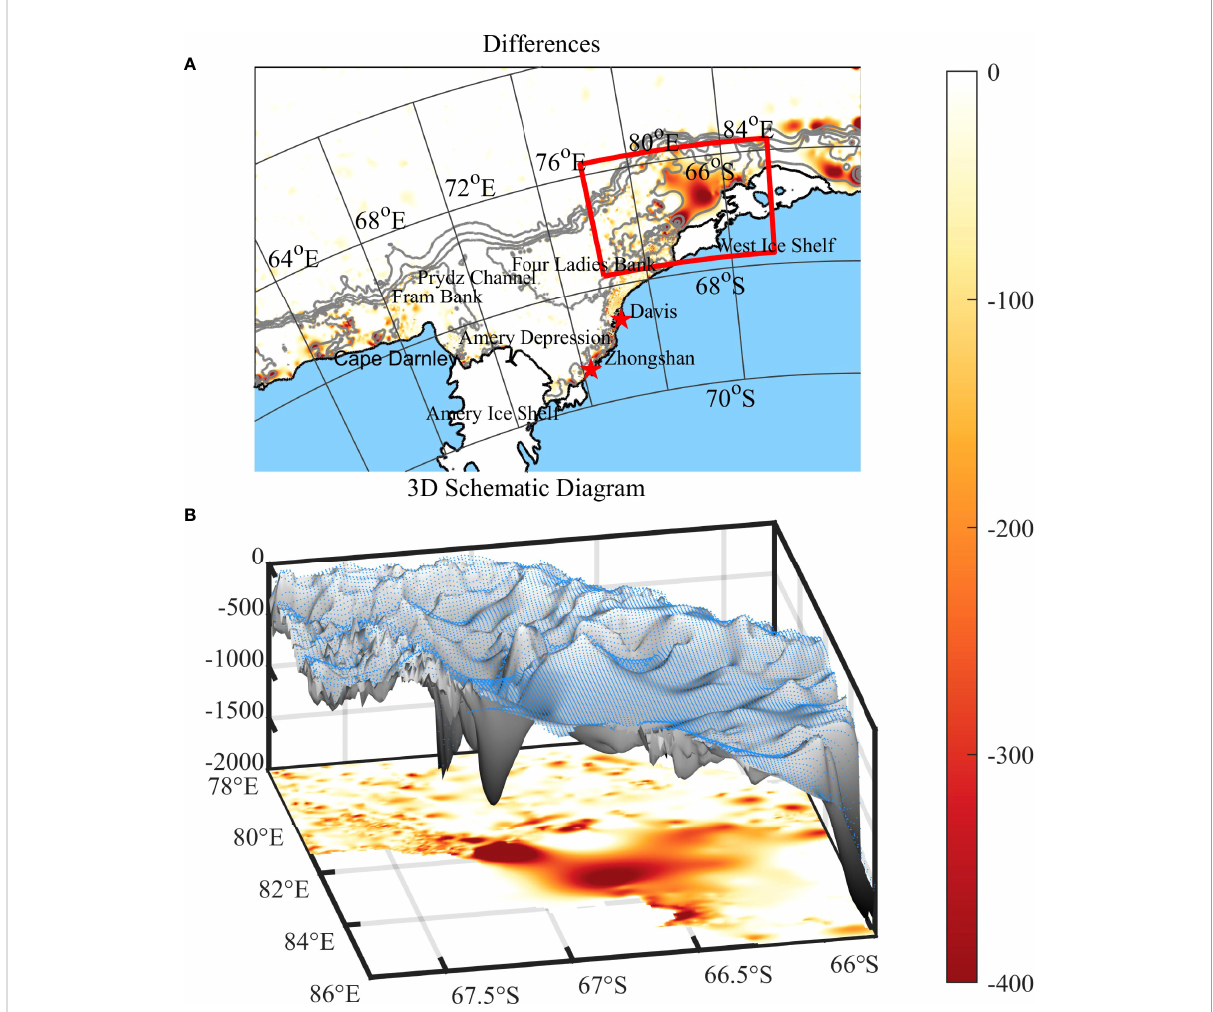
FIGURE 2 (A) Same as Figure 1B, but for the differences between the CB and IBCSO V1 (CB minus IBCSO V1). (B) The 3D schematic diagram of the bottom topography in the region bounded by the red box in (A) . The blue dot represents IBCSO V1, and the grey surface represents the CB. The bottom slice shows the bathymetry differences, which are consistent with (A)